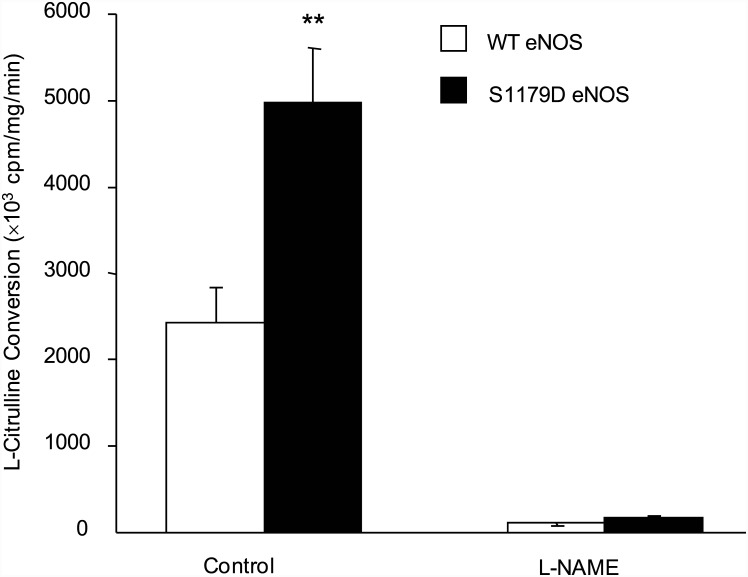
S1179D eNOS has higher rate of NO production than WT eNOS.Enzymatic activity of purified WT eNOS and S1179D eNOS preparations was assayed by monitoring the conversion of L-[14C]arginine to L-[14C]citrulline. L-[14C]citrulline production by S1179D eNOS was significantly higher than WT eNOS in control reactions (**, p<0.01,compared with WT eNOS, n = 6). No L-[14C]citrulline was produced by either WT eNOS or S1179D eNOS in the presence of the direct eNOS inhibitor L-NAME.